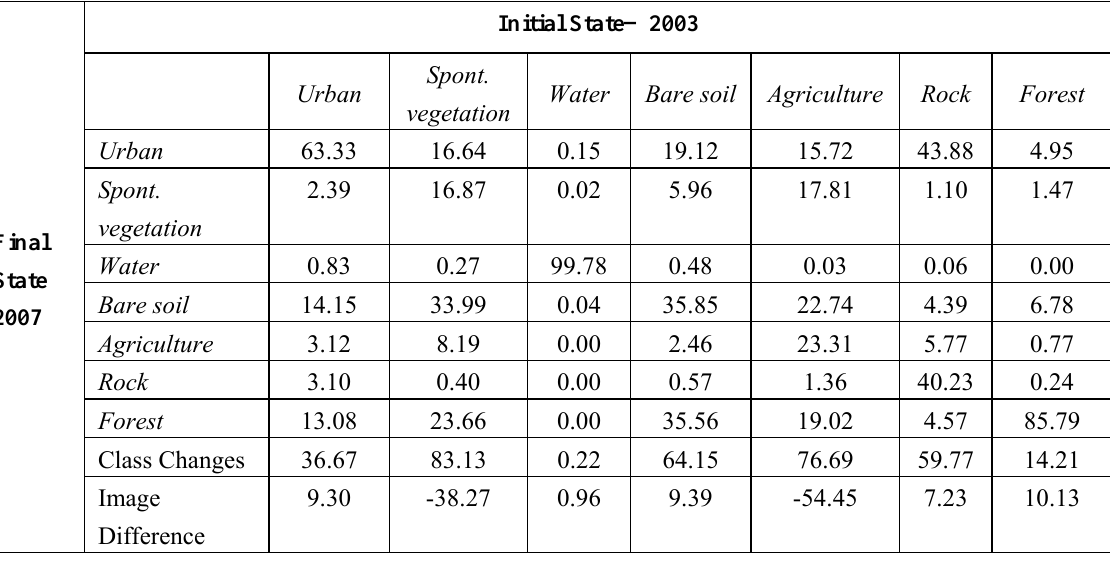
Table 4. Matrices of land cover (LC) and changes (Percentages) from 2003 to 2007.